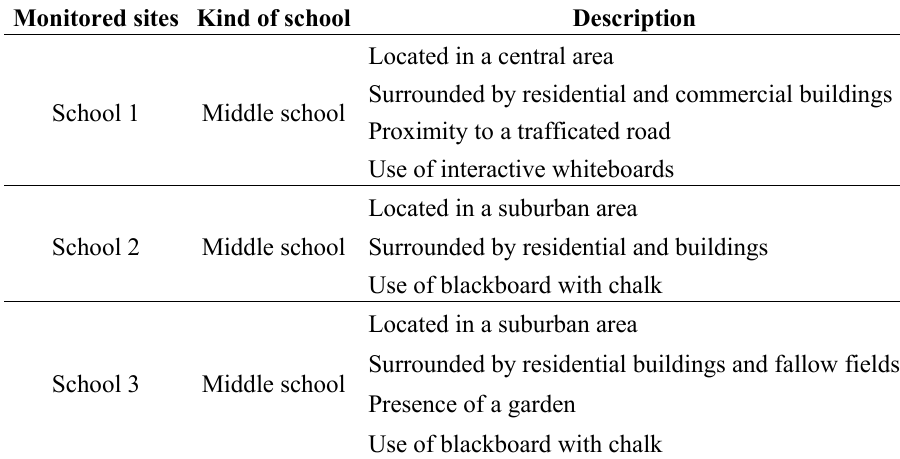
Table 1. Characteristics of monitored